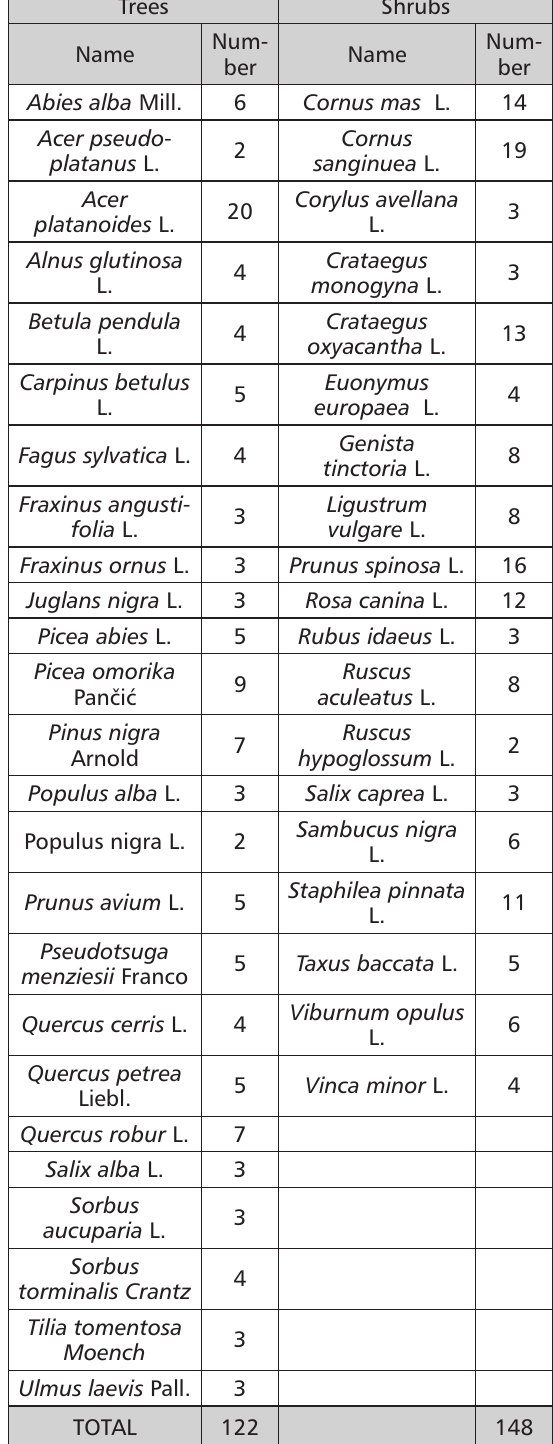
TABLE 1 List of names and numbers of tree and shrub